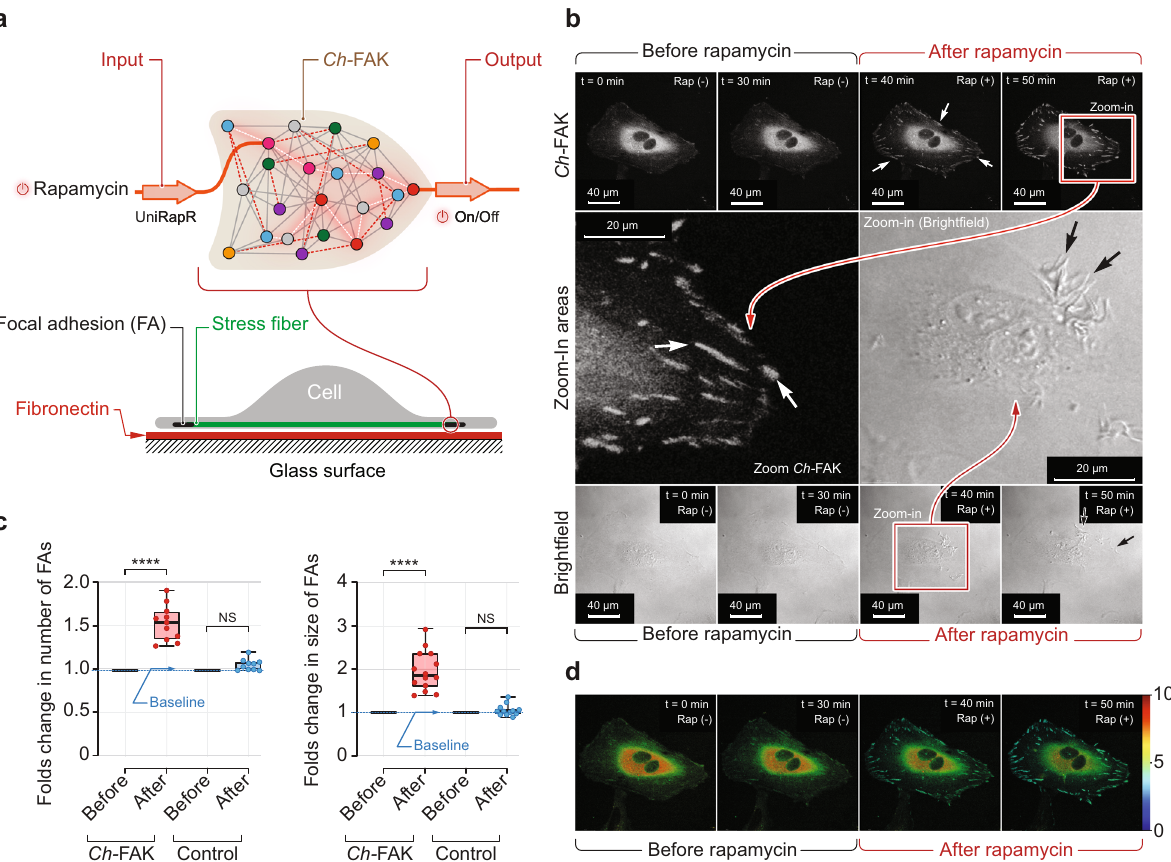
Fig. 2 Design and validation of Ch- FAK module. a Top, schematic of Ch -FAK. 50nM rapamycin is the input signal for Ch -FAK. Output is measured as Ch -FAK activation. Bottom, schematic of a cell plated on fi bronectin-coated glass surface showing stress fi bers, focal adhesions and the location of activated Ch -FAK. b Top, time-lapse fl uorescent imaging data for the mCherry-tagged Ch -FAK demonstrating rapamycin-induced activation in HeLa cells. 50nm rapamycin was added at 30th min to induce the activation. Enlarged, late focal adhesions are indicated by arrows. Bottom, time-lapse bright- fi eld images of HeLa cells that express Ch -FAK before and after addition of rapamycin. Dorsal ruf fl es are indicated by arrows. Center, zoomed-in regions of indicated images. c Normalized quanti fi cation of average size and total number of focal adhesions before and after the rapamycin addition. Control is kinase-dead mutant of FAK. Data represent box plots and individual data points. Box plots show the median (center line), fi rst and third quartiles (box edges), while the whiskers going from each quartile to the minimum or maximum. n = 11 cells for total focal adhesions (FAs) and n = 14 cells for average size of FAs from 3 independent experiments; **** P = 2.6×10 − 8 for number of FAs, **** P = 2.7×10 − 8 for size of FAs in Ch -FAK. P = 0.872 for number of FAs and P = 0.1464 for FAs size in control conditions calculated by unpaired two-tailed Student ’ s t -test. NS, not signi fi cant. d Depth analysis for the time-lapse imaging data for rapamycin- induced activation in Ch -FAK-expressing HeLa cells. Analysis was performed by measuring the distance between the glass surface and each optical planes of the cell. Distances are indicated by a color scale. Scale bar, 40 μ m. FAs indicates focal adhesions. Source data are provided as a Source Data fi